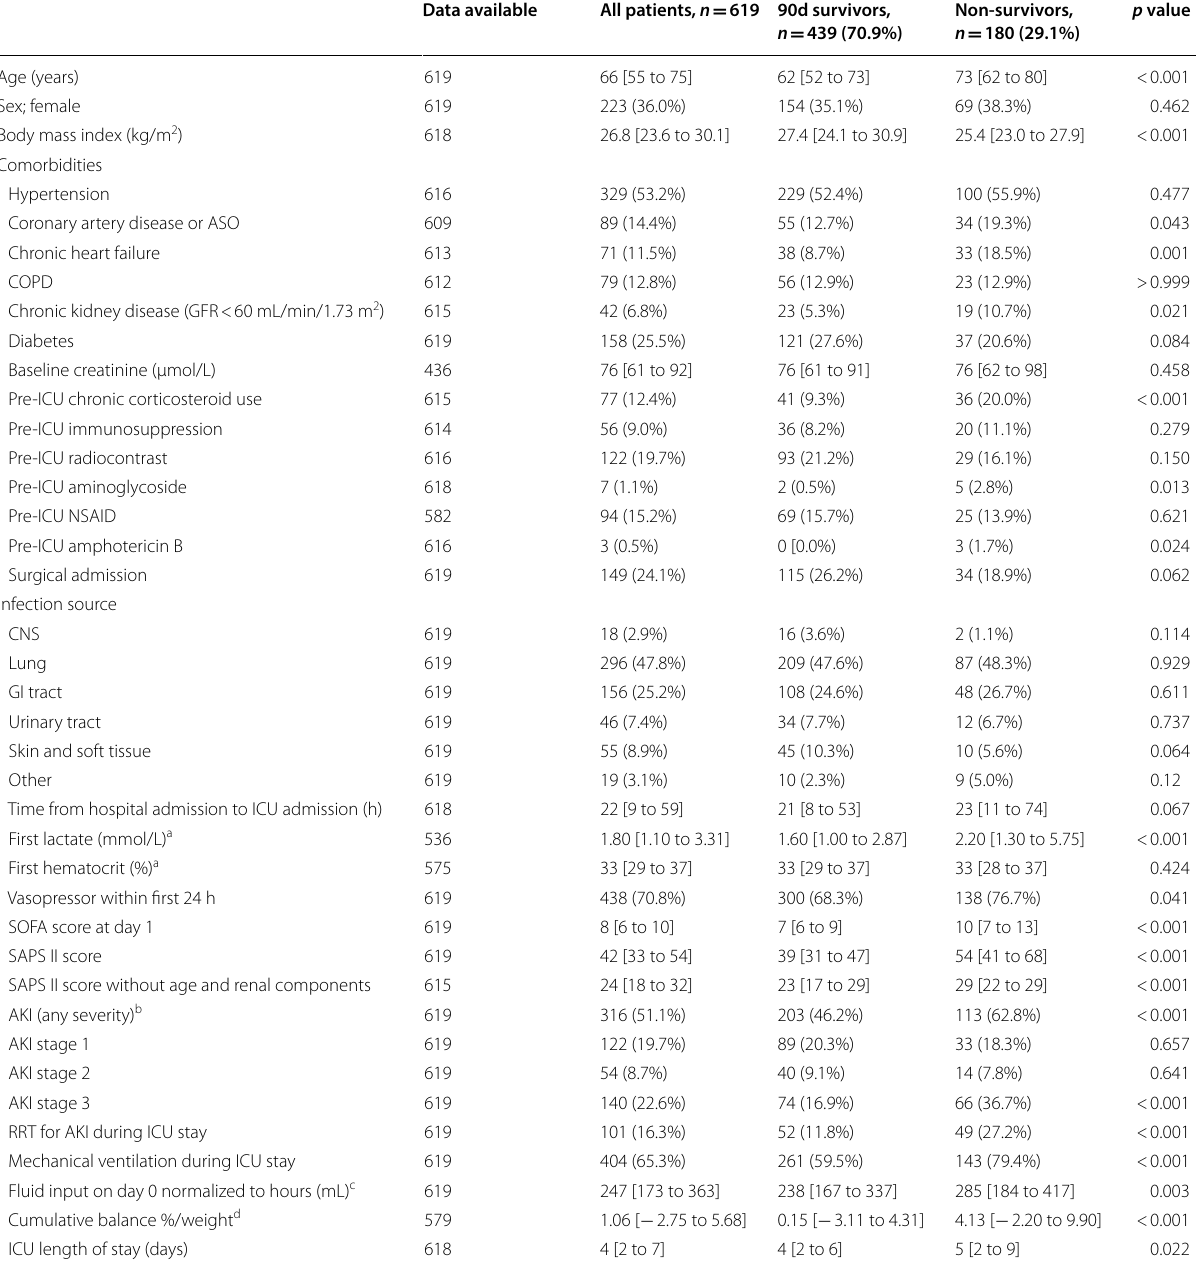
Table 1 Patient